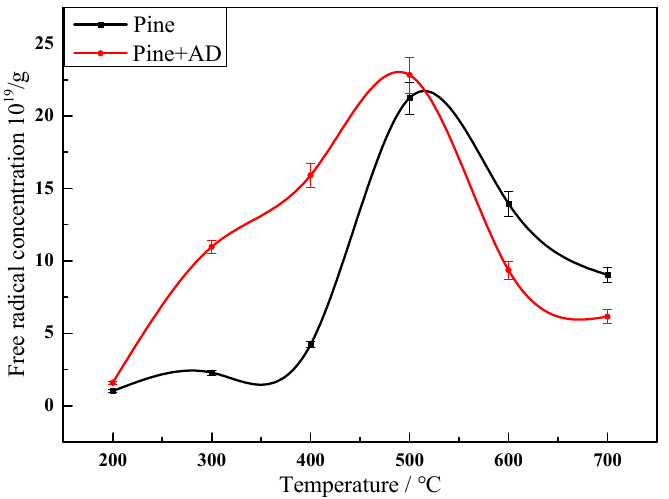
Figure 3. Variation on free radical concentrations in pyrolysis residue from pine and a mixture at different temperatures of 200–700